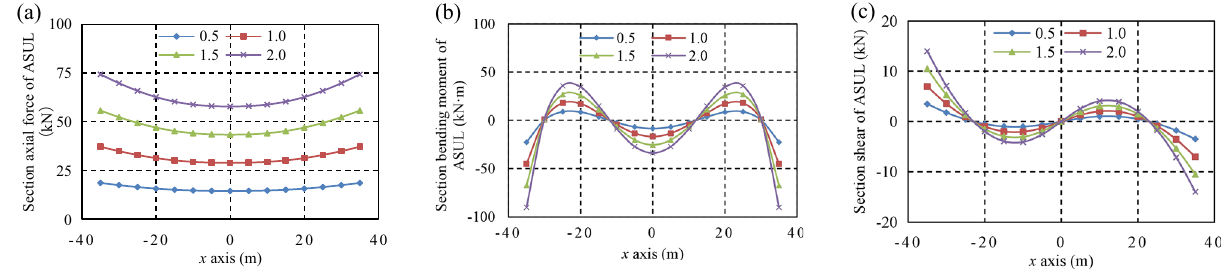
Figure 5. Internal force distribution of the ASUL under different loading: ( a ) axial force, ( b ) bending moment, ( c ) shear force.